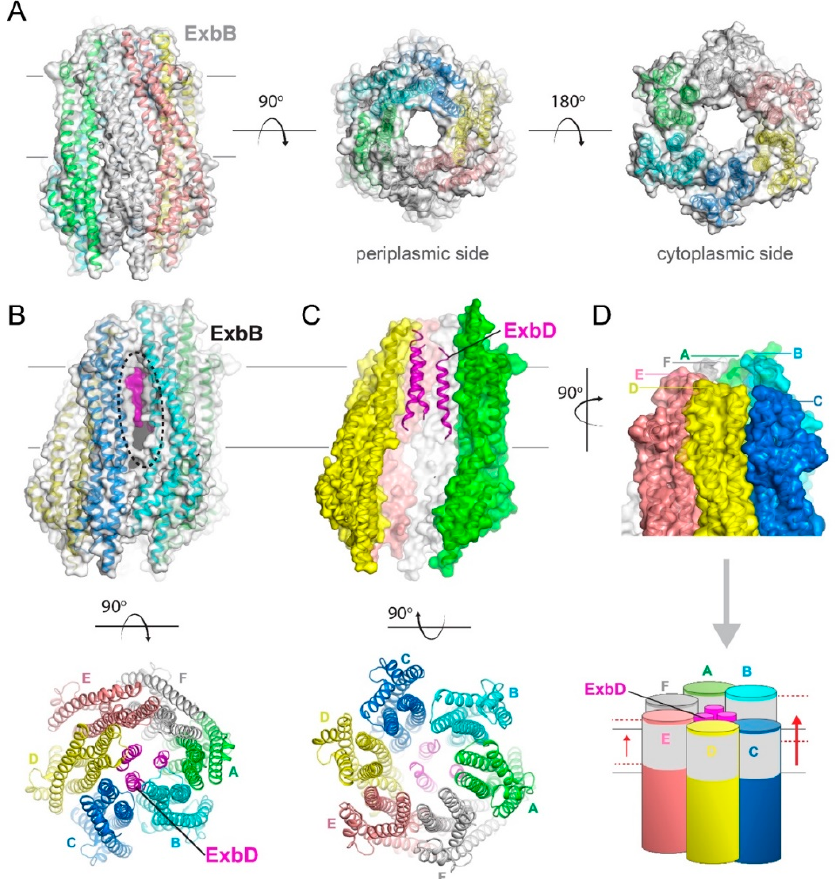
Figure 5. Structures of the hexameric ExbB/D subcomplex. ( A ) The X-ray structure of ExbB (PDB ID 5ZFP) shown in ribbon and surface. Here, ExbB is a hexamer which has 6-fold symmetry on the periplasmic and cytoplasmic sides. ( B ) The cryoEM structure of the ExbB/ExbD subcomplex (PDB ID 5ZFU) having a hexamer of ExbB and trimer of ExbD (magenta). Unlike the structure in panel A, the cryoEM structure has each ExbB monomer offset from the neighboring molecules such that chains B and C differ by ~10 Å in their positions to one another. This offset creates an unusual large portal within the membrane domain between chains B and C, as indicated by the black dashed oval, where ExbD (magenta) is easily observed. Further, due to this unusual arrangement, the membrane girdle of the ExbB hexamer is no longer symmetric, which would presumably induce a slant in the complex within the membrane as depicted in both panel ( C ) (top, chains B and C have been removed for clarity) and panel ( D ), compared to panel ( A ). In panel ( D ) bottom, the membrane domains of each monomer are depicted in gray, while the unusual shift in positions between chains B and C is highlighted by the red dashed lines and red arrow.